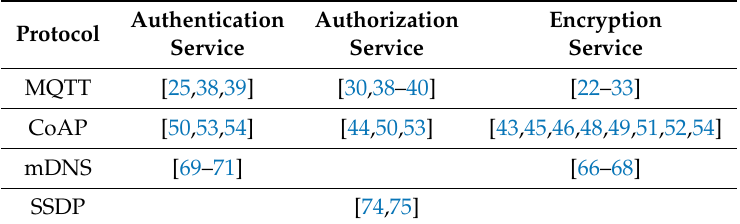
Table 6. Breakdown of the papers focusing on good practice and mitigation measures as a function of the protocol and of the security